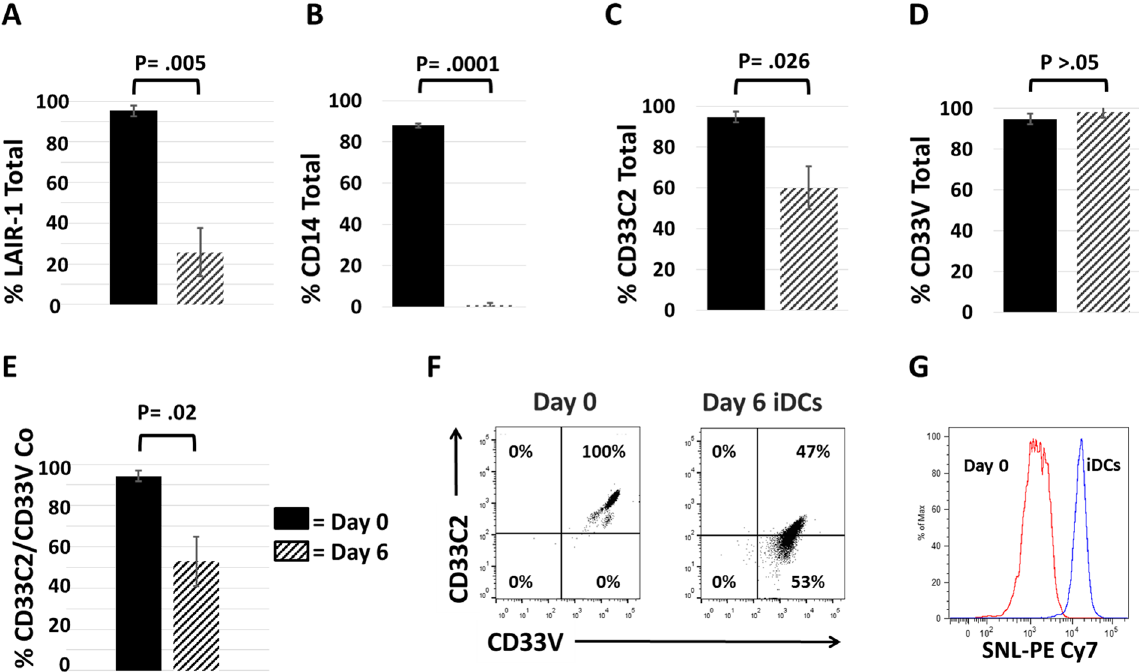
Figure 5. Maturing DCs exhibit decreases in LAIR-1 and CD14 along with a reduced ability to detect CD33C2 epitopes. ( A , B ) Decreased expression of LAIR-1 and CD14 on DCs. ( C , D ) Pooled flow cytometry data showing CD33C2 domains (detected with mAb HIM3-4) and CD33V domains (detected with mAb WM53) on freshly isolated monocytes and DCs obtained after 5–6 days of culture with 50 U/ml rGM-CSF and 50 ng/ml rIL-4. ( E ) Pooled data showing co-detection of CD33C2 and CD33V domains on fresh monocytes and day 6 DCs. ( F ) Representative dot plot comparing co-detection of CD33C2/V epitopes on freshly isolated monocytes and day 6 DCs; gates were set based on isotype controls. (G ) Increased levels of sialic acid on immature DCs detected with Sambucus nigra lectin (SNL) linked to PECy7. For ( A – E ), N = 3–5; for (G), N = 2. Two-tailed Student’s t test was used to determine significance. Solid bars represent day 0; hatched bars represent day